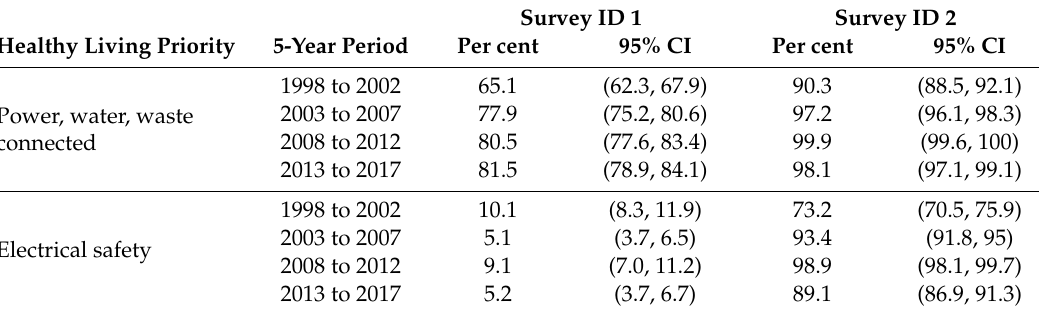
Table A4. Critical Healthy Living Priorities at Survey-Fix1 and Survey–Fix 2 by 5-year intervals from